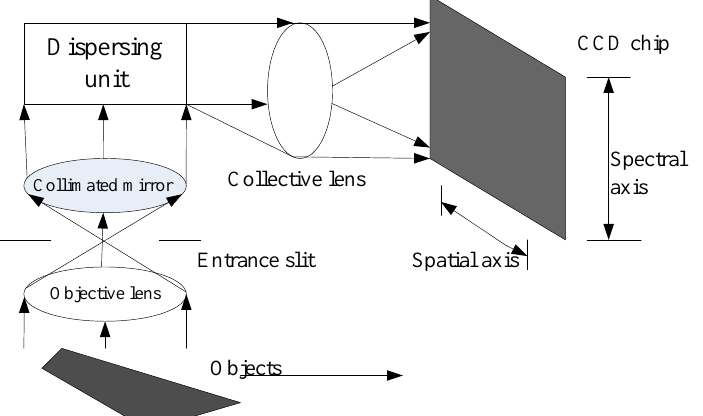
Figure 1. Basic principle of the FISS